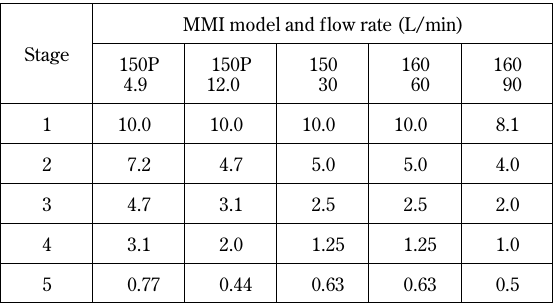
Data for 4.9 and 12 L/min are from reference 57, and data at 30 and 60 L/min are from [64]. Data at 90 L/min are calculated